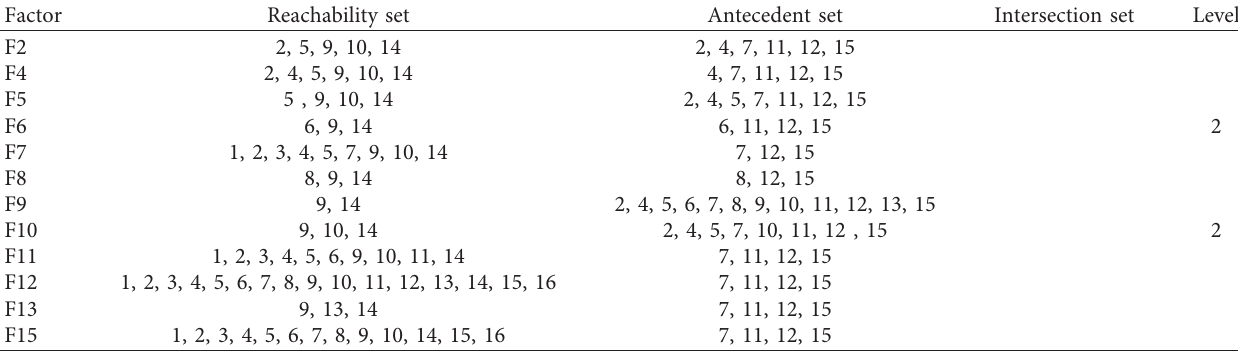
Table 5: Level partitions for level 2.